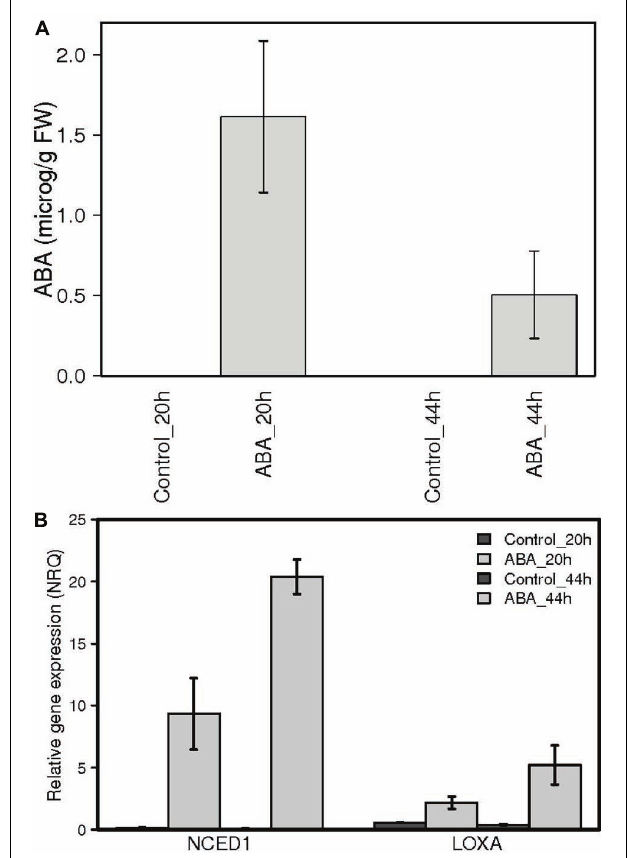
FIGURE 2 | Abscisic acid quantification and LOXA and NCED1 gene expression analysis in ABA treated berry skins. (A) ABA was measured by HPLC-MS. No ABA was detected in the untreated samples. Means of two biological replicates are represented. (B) PnLOXA and NCED1 gene expression in the skin of berries treated with 0.2 mM ABA for 20 h and then cultured on solid 10% sucrose medium without ABA for 24 h (light gray) and controls (dark gray). Normalized relative quantities were obtained by RT-PCR analysis using the two best reference genes. Data represent the mean of three biological